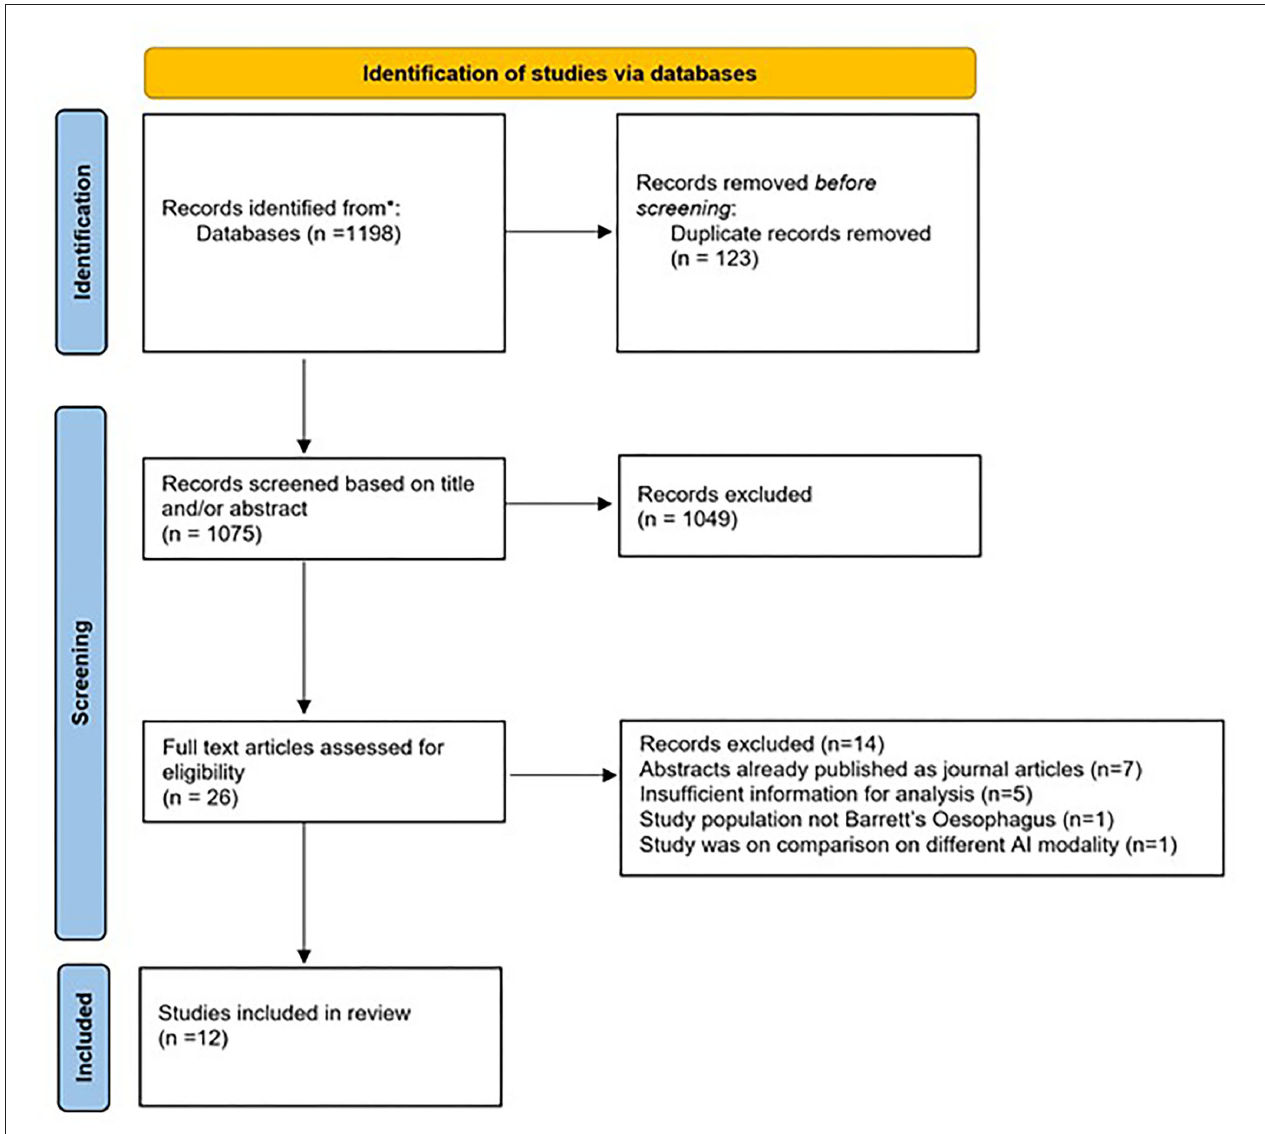
FIGURE 1 | Modified PRISMA flow diagram of the search strategy and study